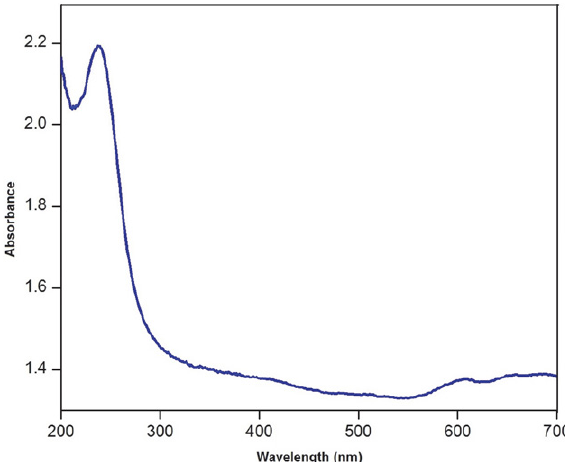
Figure 1: UV-Visible spectra of